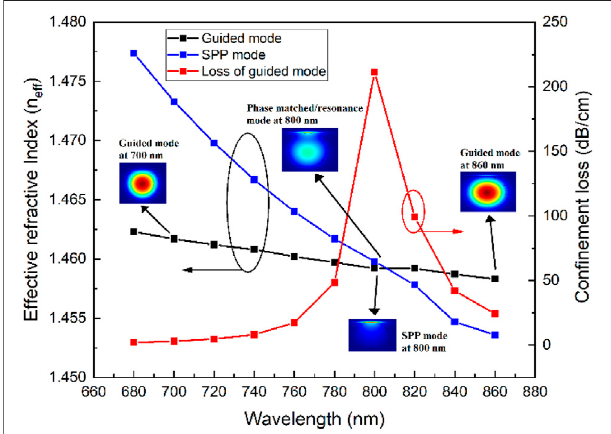
FIGURE 2 | Dispersion relations of the fundamental core-guided mode (black), SPP mode (red), and con fi nement loss spectra (black) for d (cid:2) 5 nm, t g (cid:2) 40 nm, and n a (cid:2) 1.41 with 5% GeO 2 doped silica core.